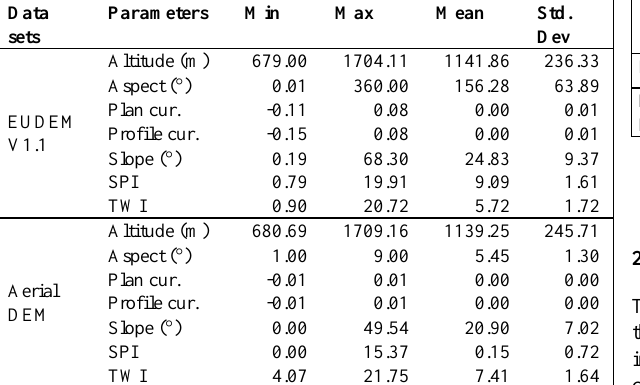
Table 4. The statistical summary of input features inside the landslide polygons located in the model training area.